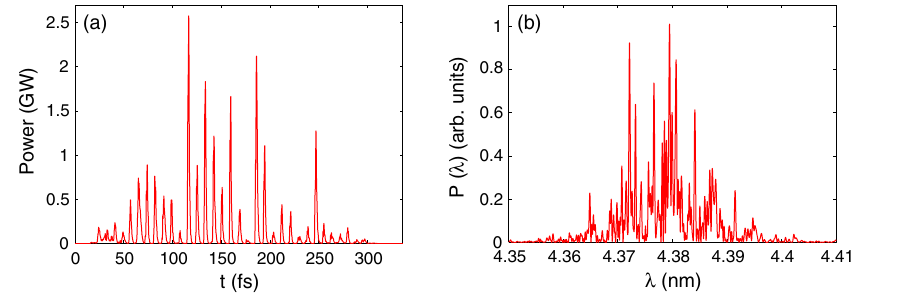
FIG. 9. FEL power and spectrum without a coherent seed.